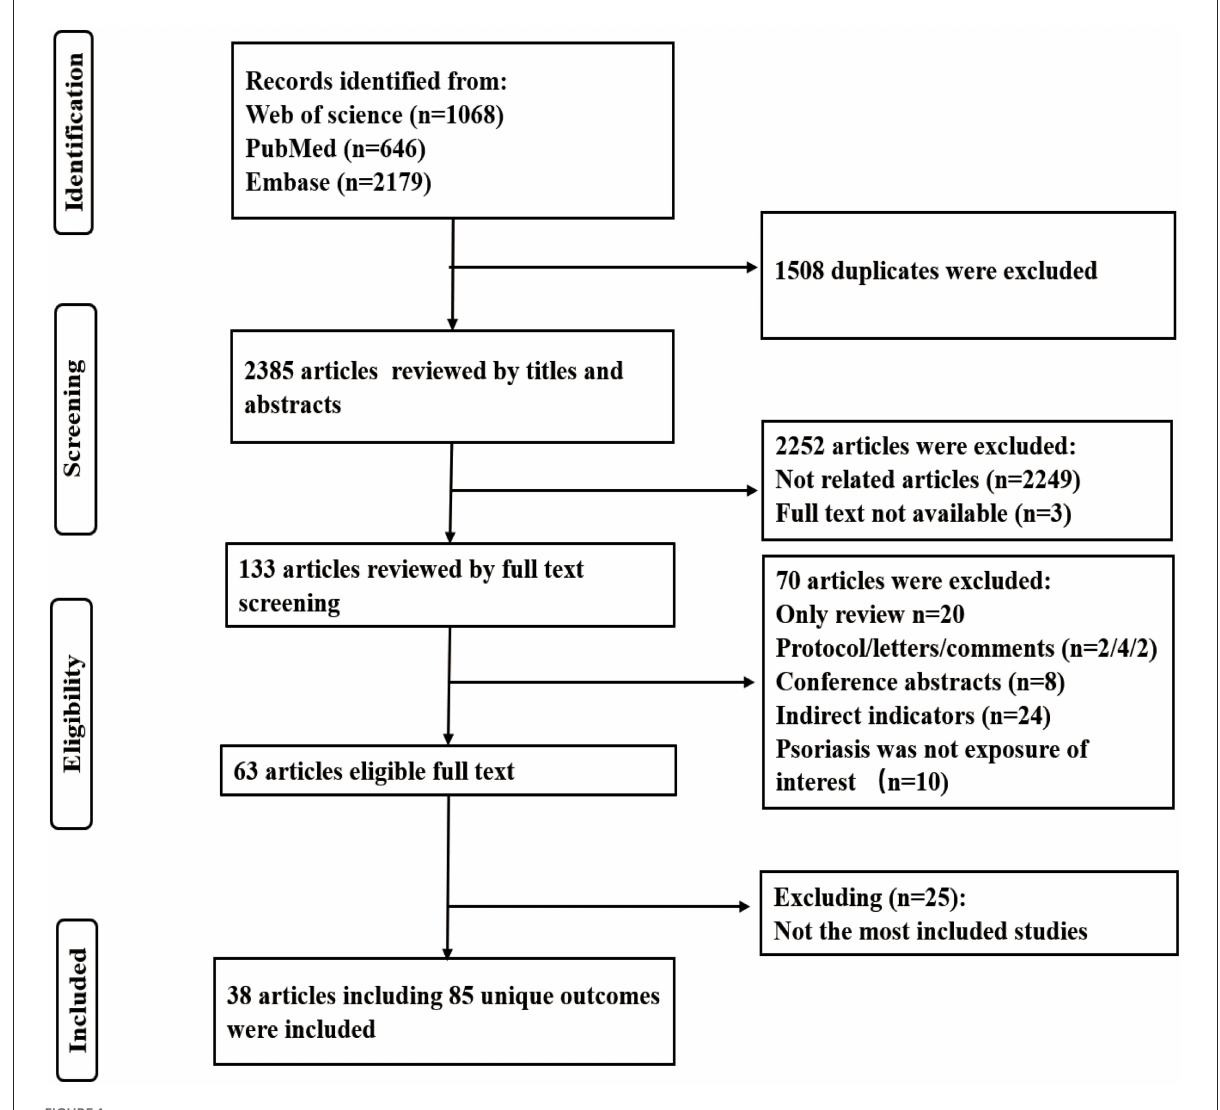
FIGURE1 The PRISMA consort flow diagram of literature search and study